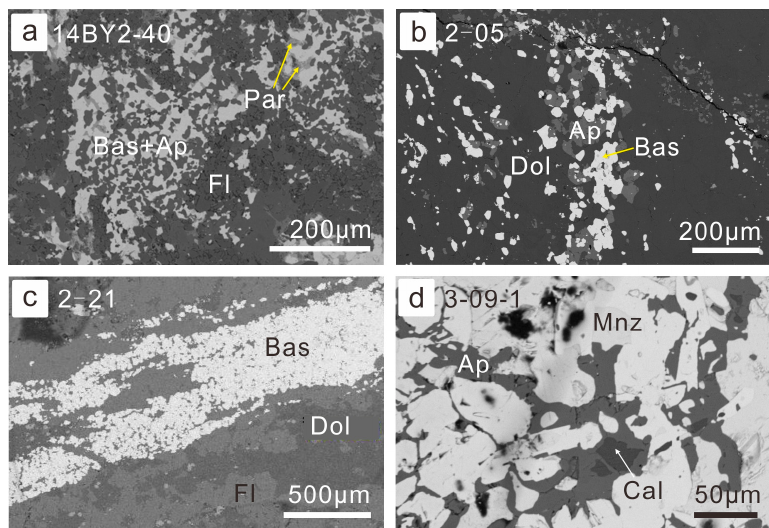
Figure 4. Petrography of association of REE minerals and gangue minerals: ( a ) the association of bastnaesite with apatite was replaced by fluorite and parisite (BSE image for sample 14BY2-40, fluorite-aegirine-rich ores); ( b ) bastnaesite association with apatite in the matrix of dolomite (BSE image for sample 14BY2-05, fine-grained ore-hosting dolomite); ( c ) banded bastnaesite aggregates in the fluorite-rich REE-Nb ores (BSE image for sample 14BY2-21); ( d ) monazite was corroded from grain boundaries and replaced by apatite and calcite (BSE image for sample 14BY3-09-1, banded REE-Fe ore).